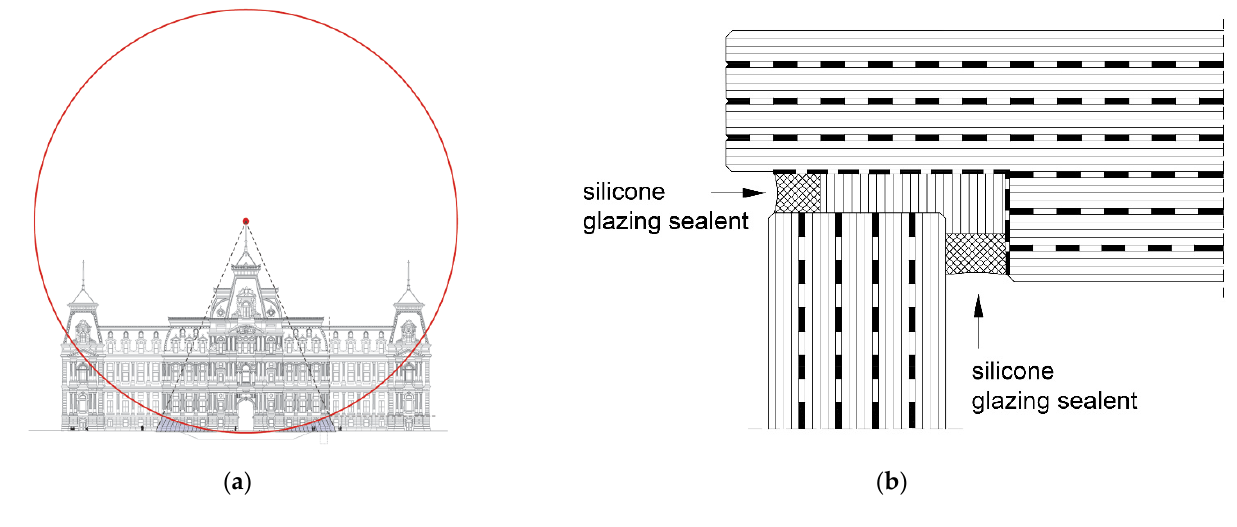
Figure 26. The underground station Dilworth Park in Philadelphia: ( a ) form of pavilions (© Kieran- Timberlake), ( b ) detail of roof plate–wall connection (developed by the author based on [112]).